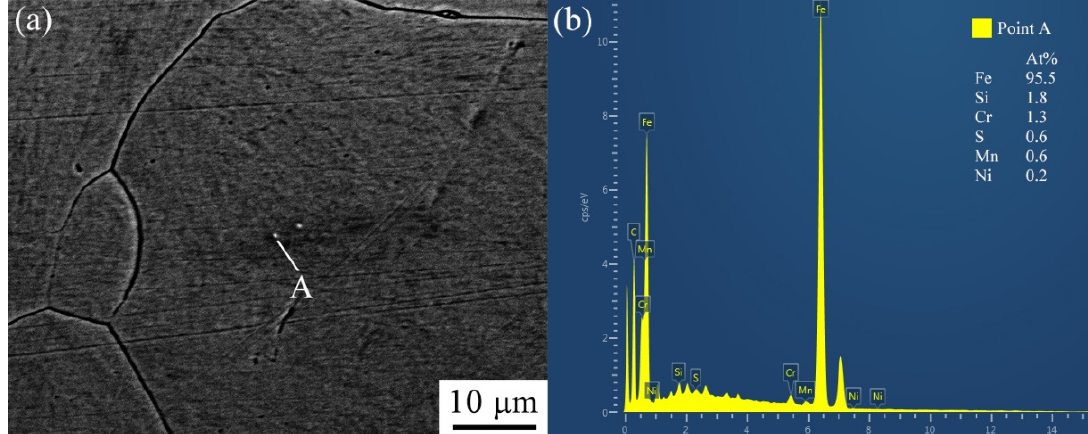
Figure 3. The MnS weight fractions ( a ) and the MnS element constitutions ( b ) in 40Cr and Q345B at temperatures between 950 and 1200 °C.